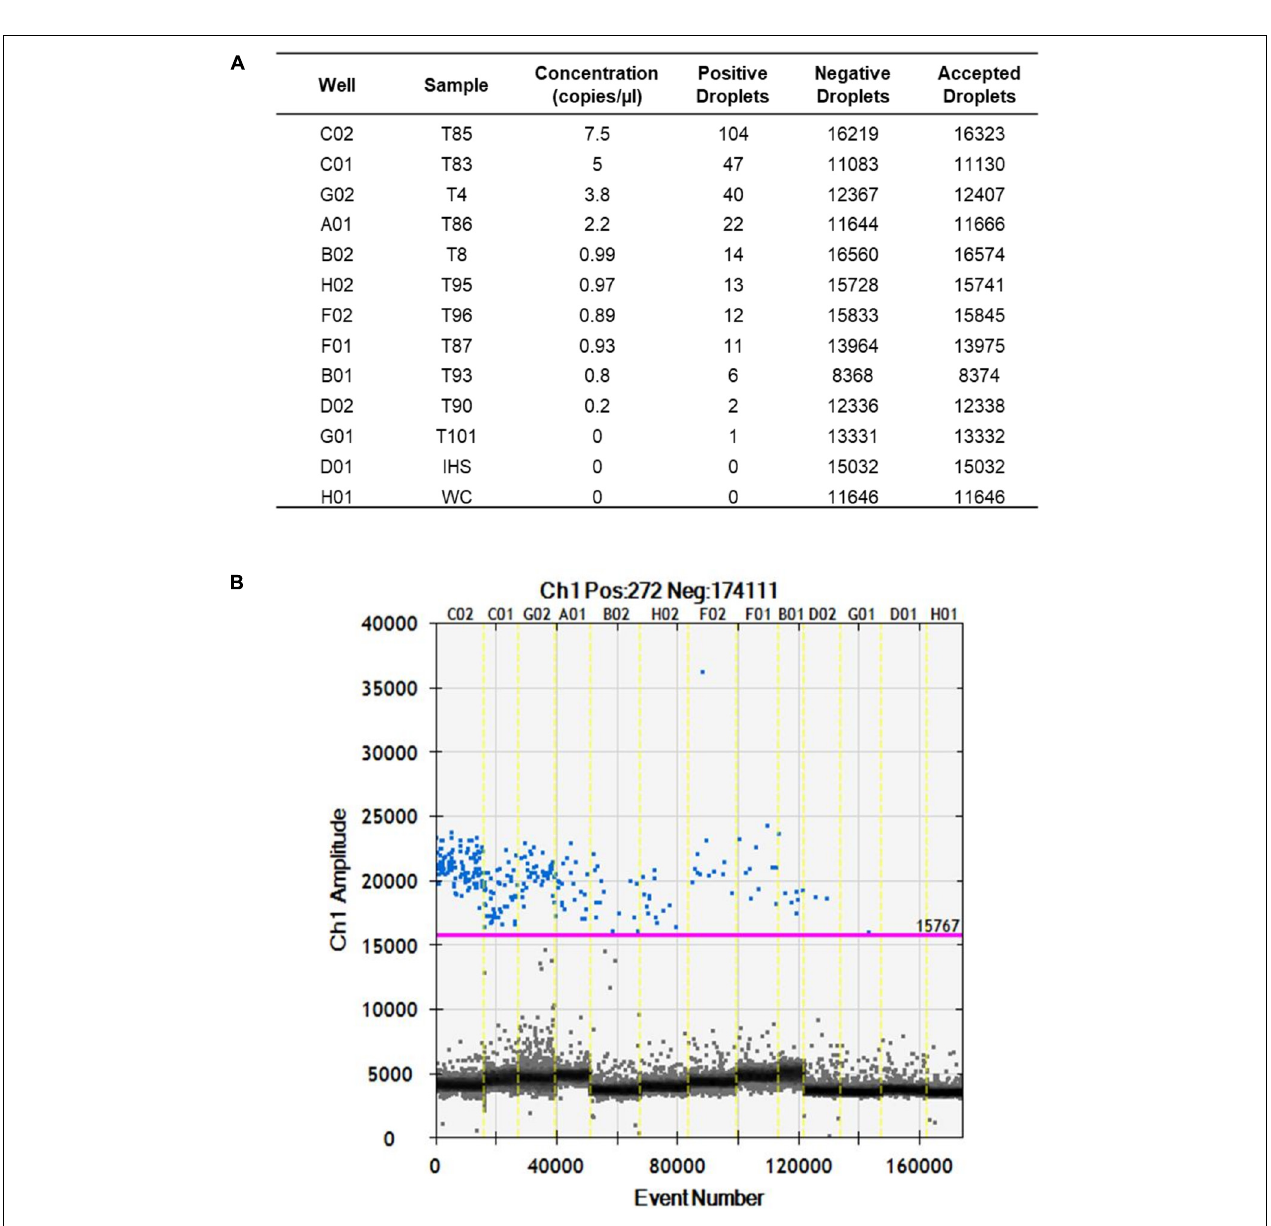
FIGURE 3 | Fluorescence amplitudes of S. cucurbitacearum in the naturally infected seed samples (as indicated) and controls (IHS and WC) using ddPCR. (A) Absolute quantification. (B) Fluorescence